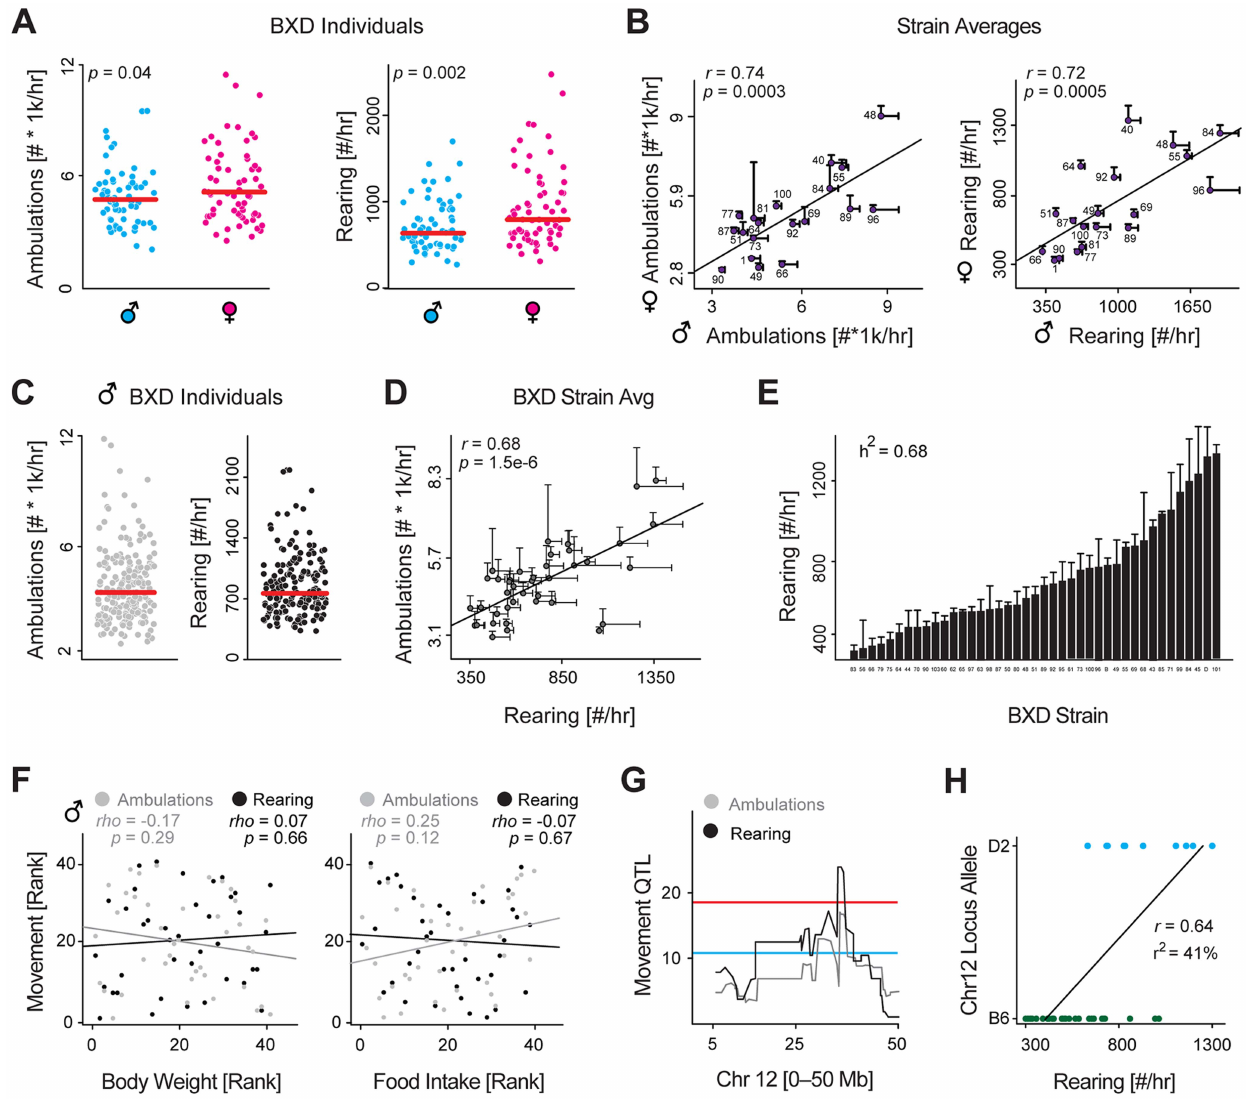
Figure 1. Identification and validation of a movement QTL. ( A ) Nighttime rearing and ambulatory activity for all 68 males and 68 females phenotyped across 22 (male) and 19 (female) strains. These 19 strains were phenotyped in both sexes. Females are slightly more active. ( B ) Despite moving somewhat more, female and male activity are strongly correlated by strain. ( C ) Nighttime rearing and ambulatory activities for all 196 animals across 43 strains. Each strain has , 5 biological replicates. ( D ) Ambulatory and rearing activity are tightly correlated, though the measurements are technically independent. ( E ) Nighttime rearing activity for all 43 strains, ordered by value. Activity varies by 3.9 fold across the population. The strong heritability (h 2 ) of 0.68 indicates that the majority of this variance can be attributed to genetic factors. ( F ) Body weight (Left) and food intake (Right) have no effect on ambulatory or rearing activity, suggesting movement is largely independent of the weight or the need to eat or drink. Animals must rear to reach the food basket or drink. ( G ) Rearing and ambulatory movement mapped to a common narrow 2 Mb locus on chromosome 12. ( H ) The target locus (chromosome 12 from 35.5–37.6 Mb) explains , 40% of variance (r 2 ) in rearing activity and , 25% of variance in ambulatory